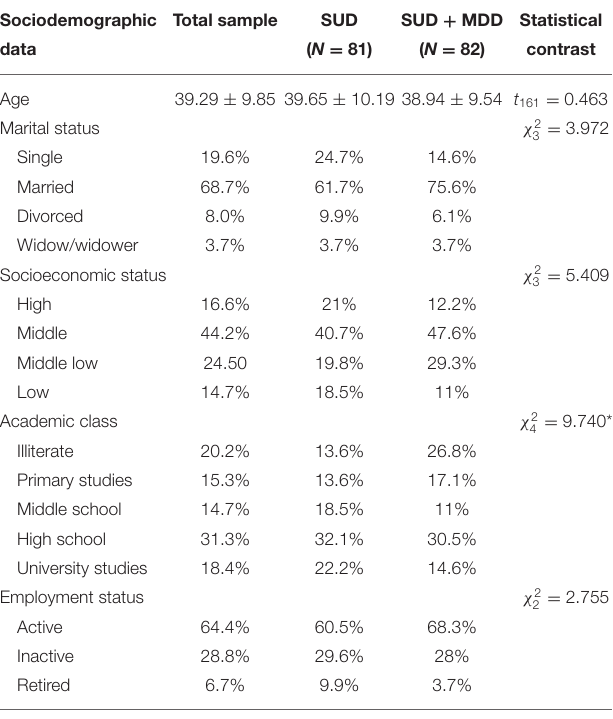
TABLE 1 | Sociodemographic variables for the total sample, SUD, and SUD + MDD groups. Sociodemographic Total